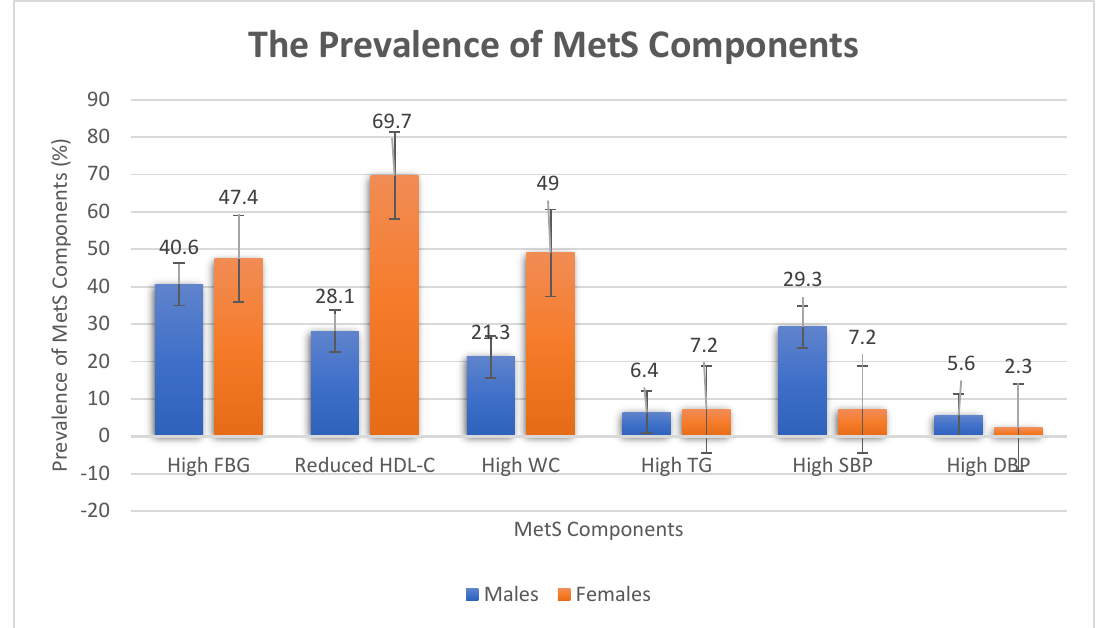
Figure 2. Gender-specific distribution of MetS components among Ellisras young rural adults aged 22 – 30 years. As shown in Table 2, males had no significant mean difference in any of the MetS components with SSBs quartile ( p > 0.05). There was a significant mean difference be- tween the first SSB quartile and WC ( p < 0.05) in females. Subsequently, a significant mean difference was also observed between DBP and the fourth SSBs quartile ( p = 0.025) in females. Table 2. The multiple comparisons for the observed mean of Ellisras young rural adults aged 22 – 30 years.